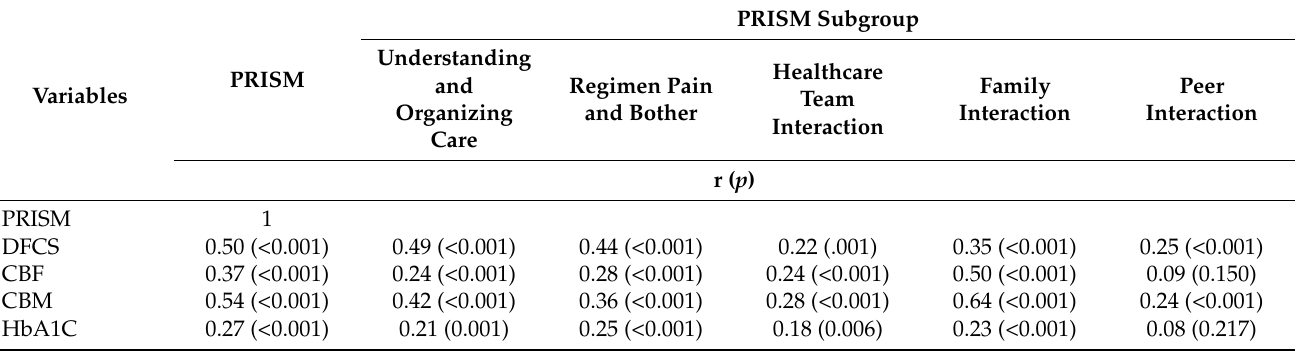
Table 4. Correlations between the examined variables ( n =